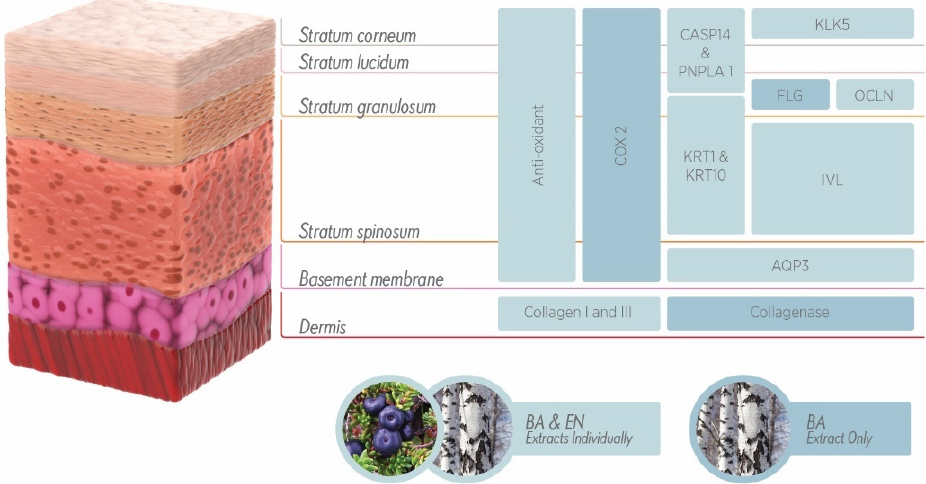
Figure 7. Schematic illustration of the multidirectional effects of BA and EN extracts on the